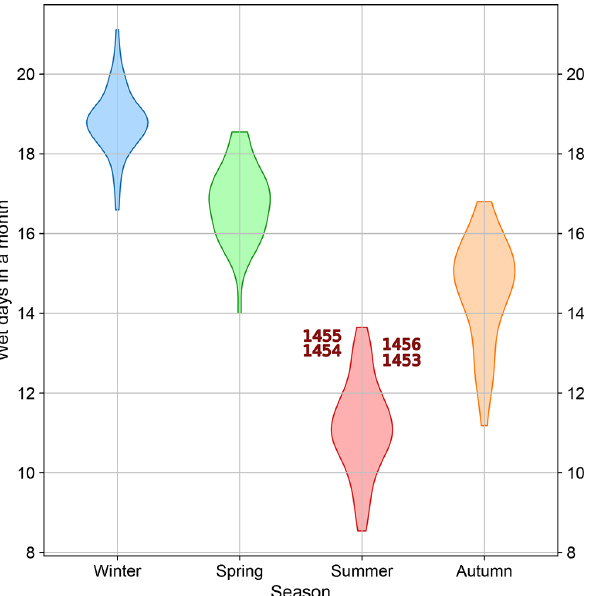
Figure 9. Distribution of average wet days in a month over the Bur- gundian Low Countries from 1420 to 1499CE after data assimila- tion using the ModE-Sim ensemble as the prior. Depicted in red are the four summers following a strong volcanic eruption in late 1452CE (or early